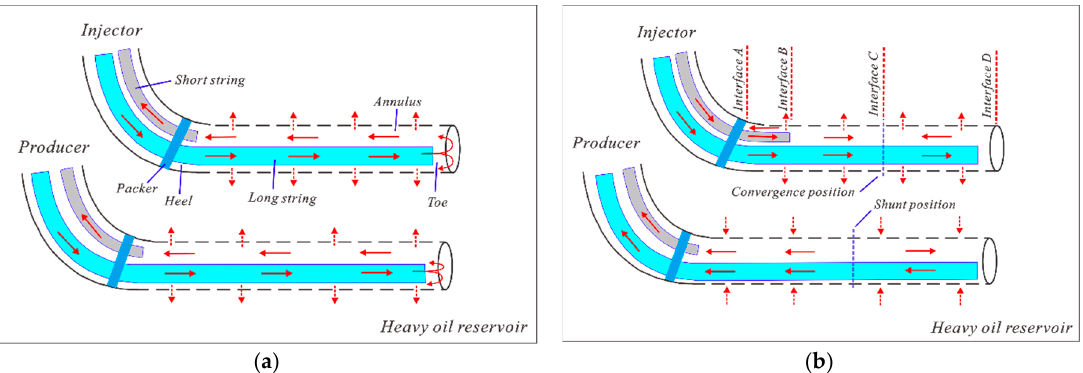
Figure 2. Schematic of the fluid flow in dual-string horizontal wells during the SAGD process: ( a ) circulation stage; ( b ) SAGD operation. ( a ) circulation stage; ( b ) SAGD